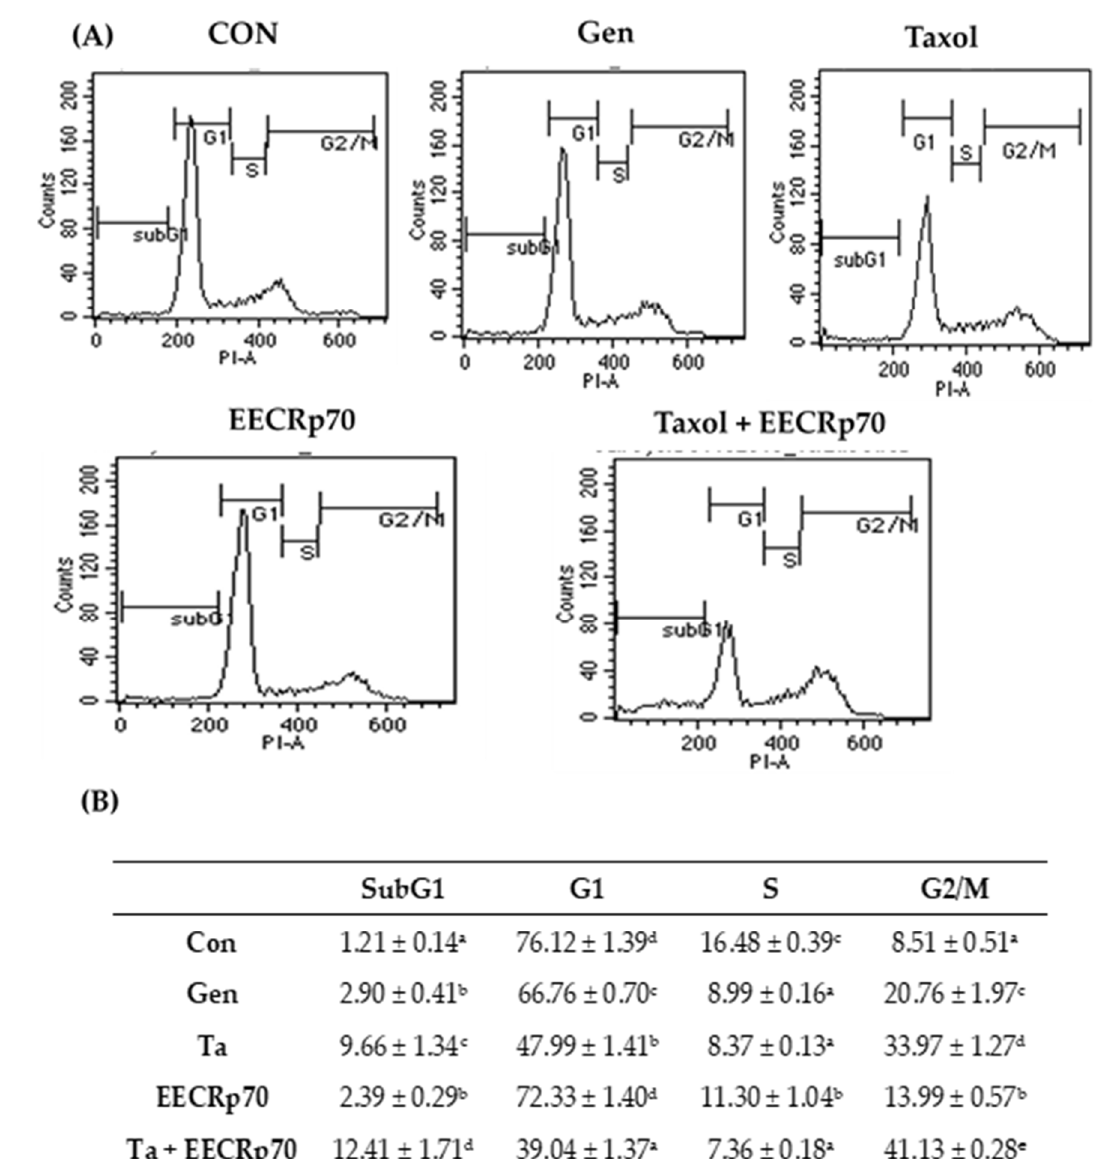
Figure 6. Change in cell cycle distribution of SCC25 cells treated with EECRp70. Cells were incubated with 25 µ M genistein, 10 nM taxol, 25 µ g/mL EECRp70, and 10 nM taxol + 25 µ g/mL EECRp70 for 24h. Cells were collected and stained with PI/RNase solution, and the cell cycle was measured by flow cytometry (FACScan). ( A ) Representative cell cycle profiles of EECRp70 treated SCC25 cells. ( B ) Cell cycle of distribution statistics (%). Data as mean ± SD, n = 3, p < 0.05 in each column not having the same superscript are significant differences.